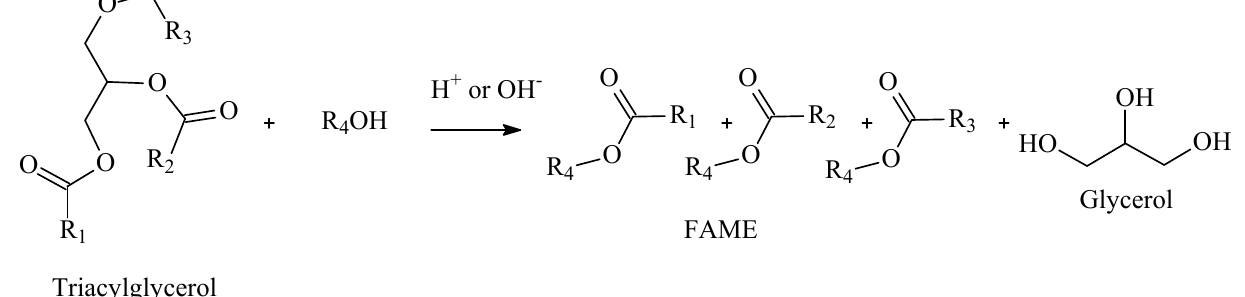
Figure 1. Conversion of feedstock to FAME.